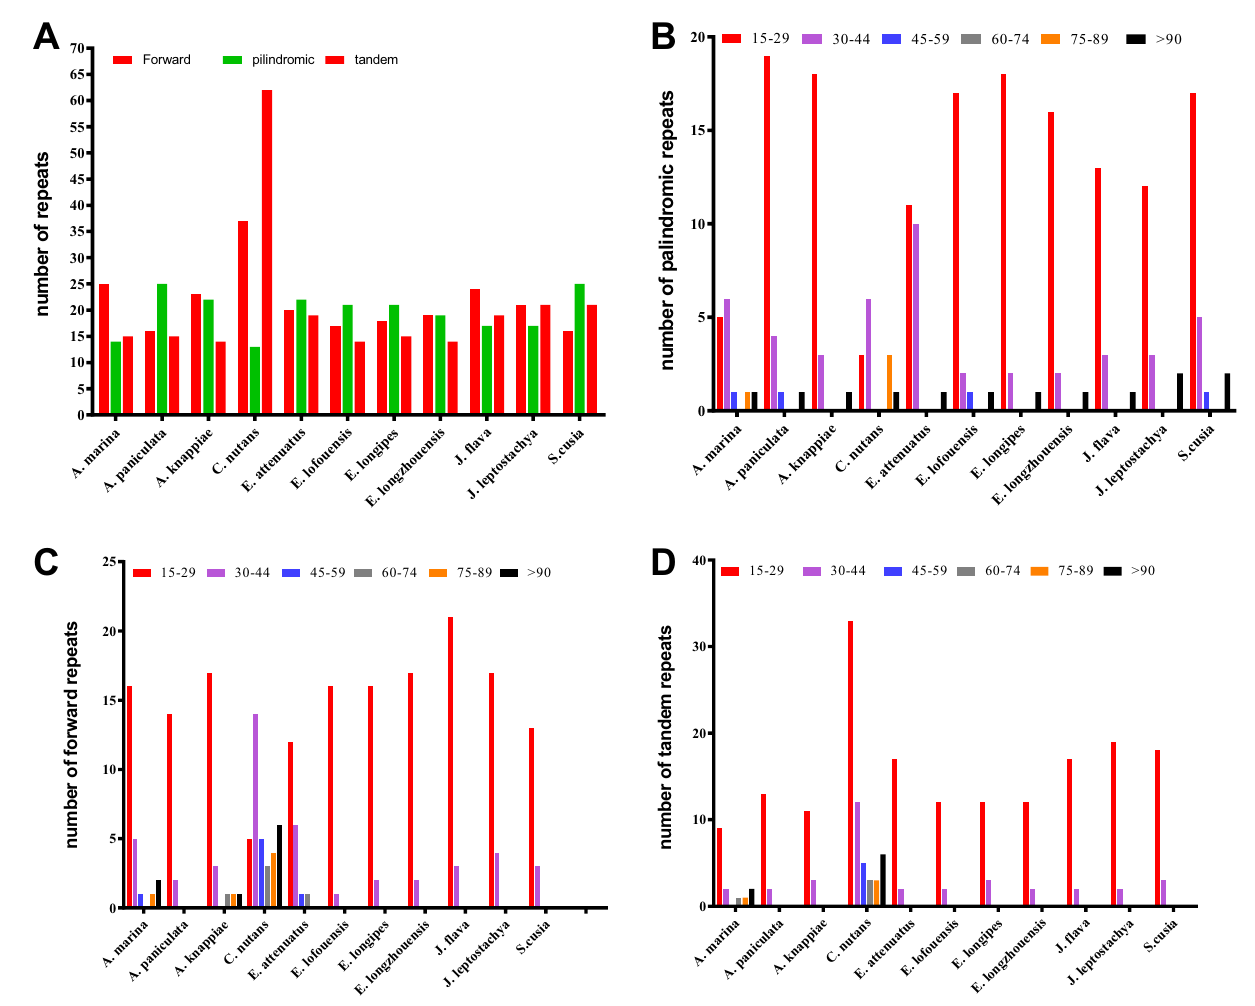
Figure 4. Distribution and frequency analysis of repeated sequences in chloroplast genome of A. marina. ( A ) total number of forward, palindromic and tandem repeats. ( B ) distribution of palindromic repeats in different ranges of length. ( C ) distribution of forward repeats in different ranges of length. ( D ) distribution of tandem repeats in different ranges of